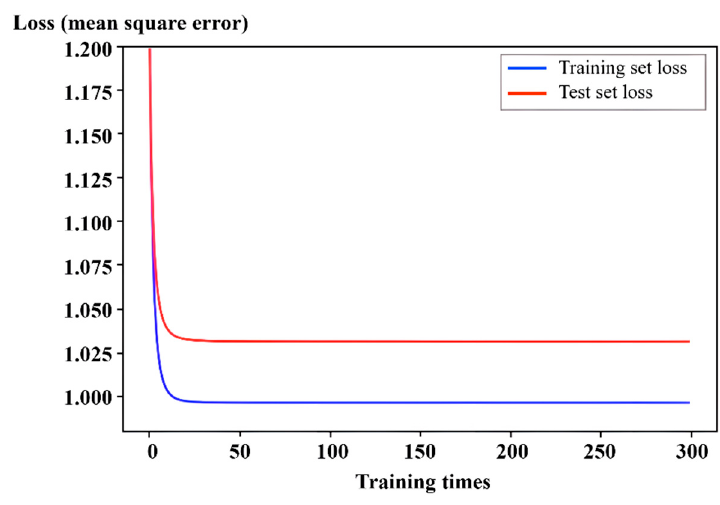
Figure 18. Attack process for certain load samples.